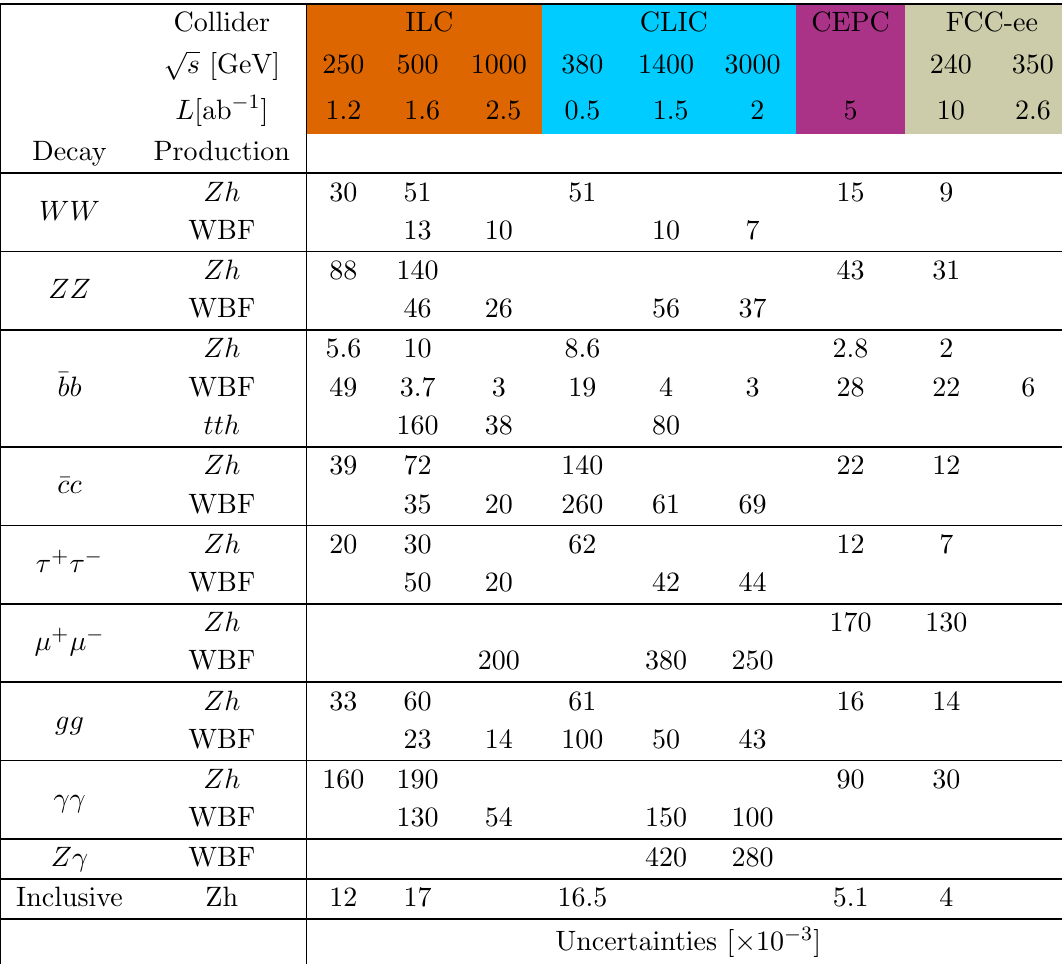
Table 8 . Inputs for the Higgs signal strength’s uncertainties at ILC [151], CLIC [151, 154], CEPC [153] and FCC-ee